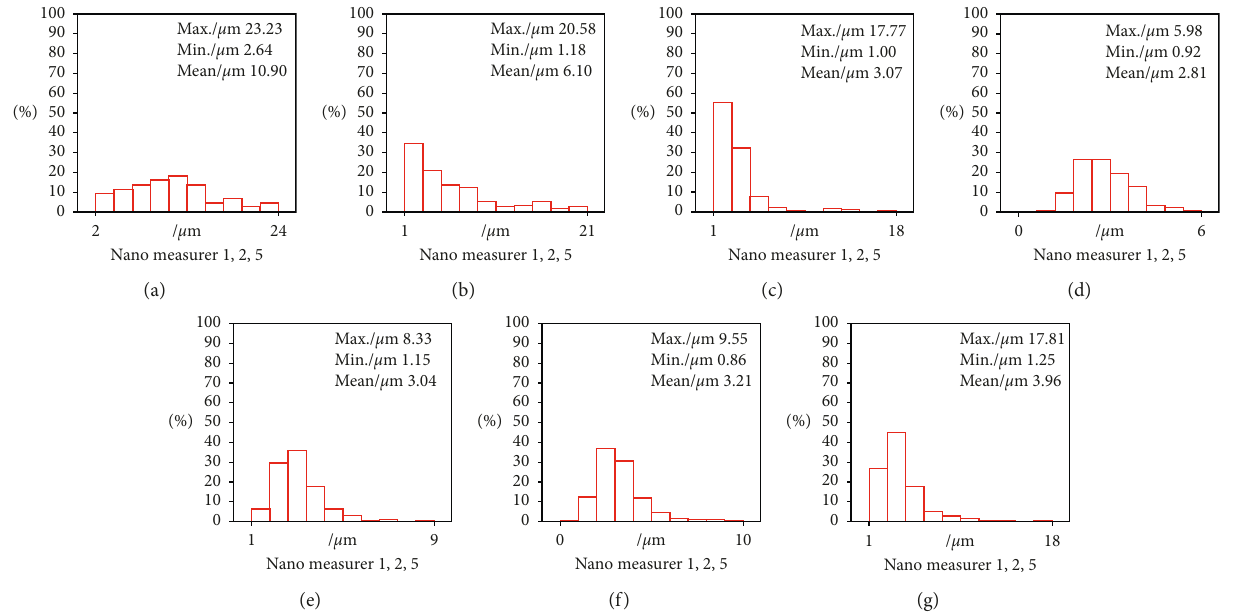
Figure 7: The Gd211 particle distribution of the GdBCO samples prepared with PSPP sintered at different temperatures. (a) S1 (25 ° C), (b) S2 (950 ° C), (c) S3 (1000 ° C), (d) S4 (1050 ° C), (e) S5 (1100 ° C), (f) S6 (1150 ° C), and (g) S7 (1200 °